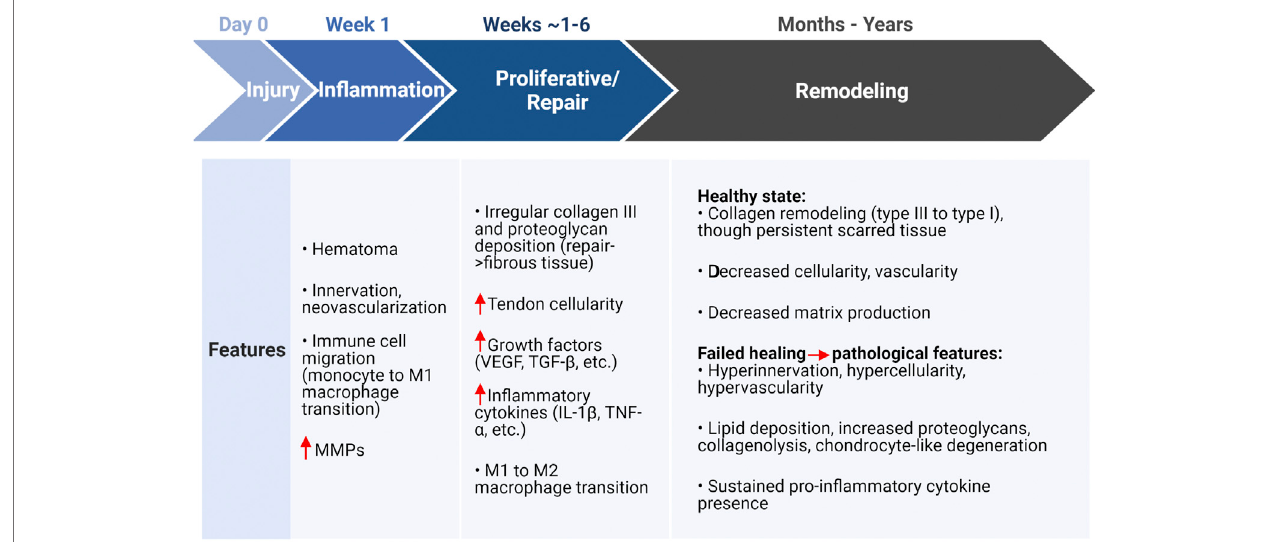
FIGURE3| Tendonhealingestimatedtimelineandfeaturesassociatedwithahealthyorpathologicalstatefollowinginjury.CreatedwithBiorender.com.Initialinjury duetooverloadinginducesanin fl ammatorystatethatischaracterizedbymatrixdegradation,cellapoptosis,andimmunecelllocalization(monocytes)thattransitiontoa pro-in fl ammatory (M1) macrophage for removal of cell and ECM debris. The proliferative or repair phase (estimated 1 – 6 weeks) is characterized by injury site repair via increased cellularity, growth factors, in fl ammatory cytokines, and eventually the in fl ammation resolving M2 macrophage transition. The fi nal remodeling stage can take months to years, where pathological features may persist with sustained in fl ammatory cytokines (though not immune cells) and degeneration of the ECM. In either the healthy or pathological case, a persistent scar-like tissue remains present (Fu et al., 2010; Lipman et al., 2018; Alim et al., 2020; Gracey et al., 2020). MMPs, matrix metalloproteinases; VEGF, vascular endothelial growth factor; TGF- β , transforming growth factor β ; IL-1 β , interleukin-1 β ; TNF- α , tumor necrosis factor α